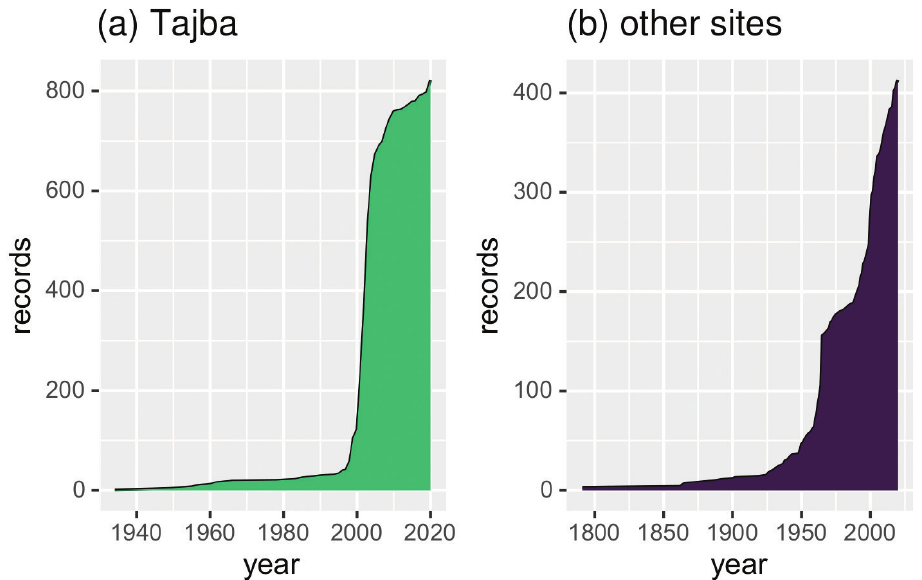
Figure 2. Cumulative plots of ( a ) all distribution data in the Tajba NNR and ( b ) other sites in